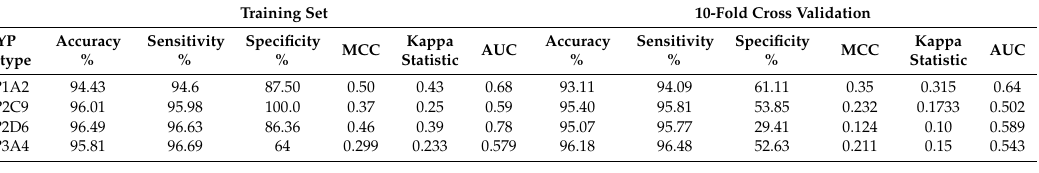
Table 4. The model evaluation parameters for the inhibitor-based decision tree classifiers of CYP1A2, CYP2C9, CYP2C19, CYP2D6 and CYP3A4. MCC: Matthews correlation coe ffi cient; AUC: Area under the curve.